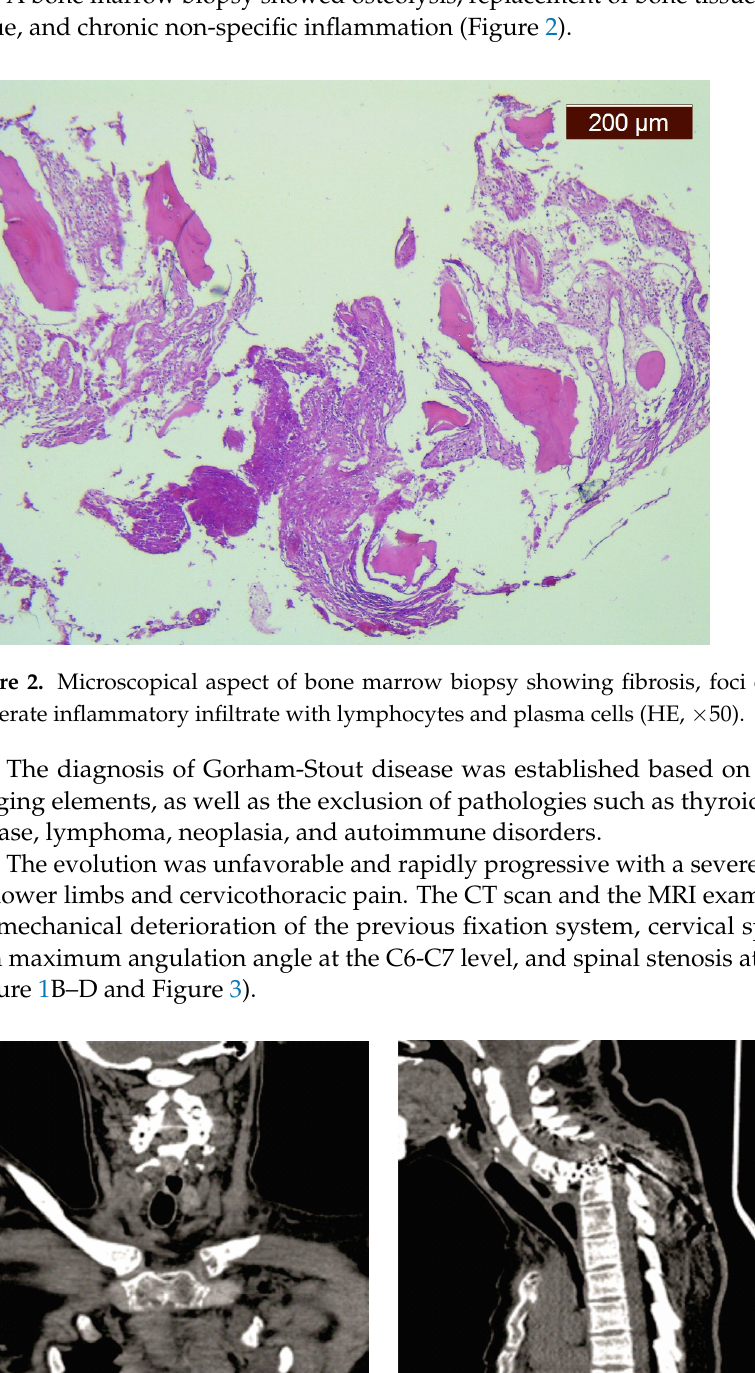
Table 2. Surgical treatment . Time Surgical Treatment